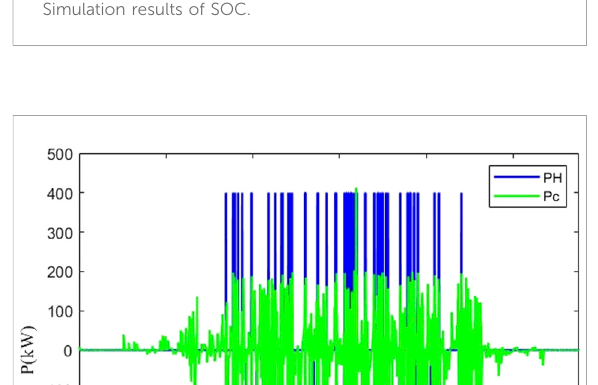
FIGURE 9 Simulation results of SOC.